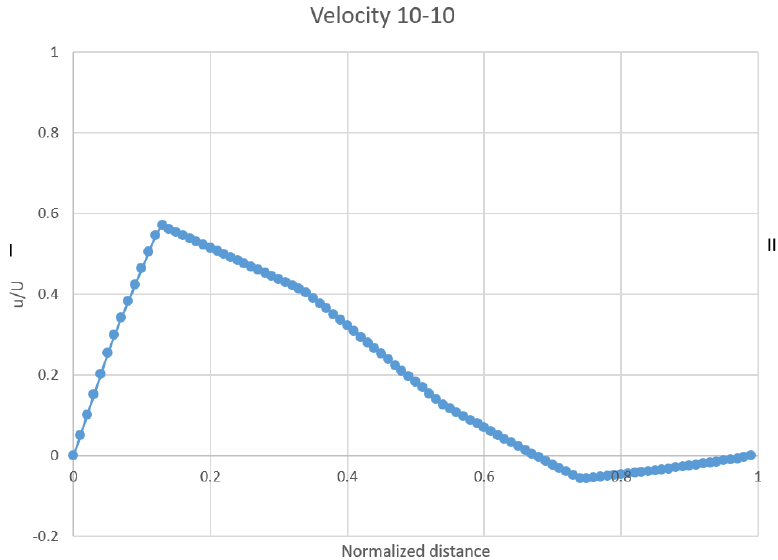
Figure 14. Velocity profile at cross-section (10-10) in the gap between containers.